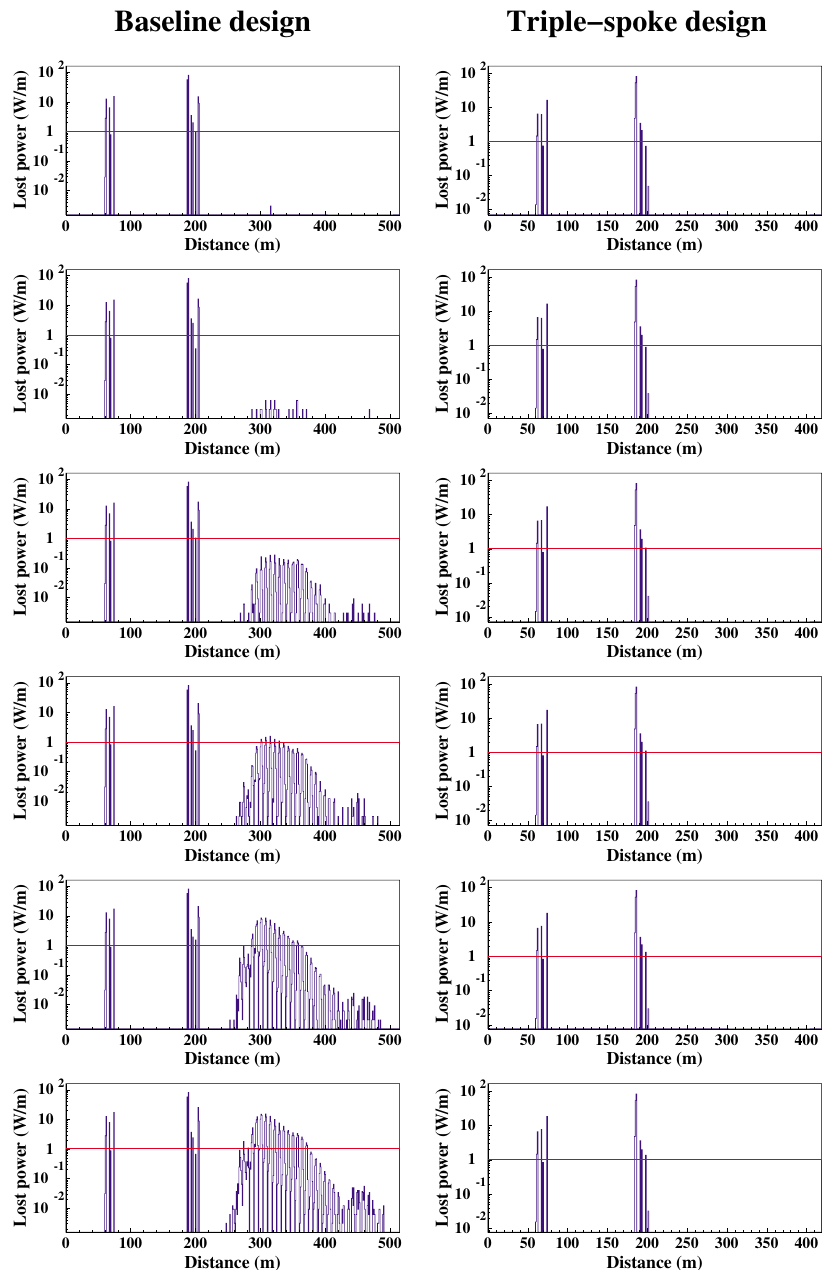
FIG. 16. (Color) Beam power lost along the accelerator in W = m for both the baseline and triple-spoke design and the error combinations of Table II. The plots are for combination 1 (top) to combination 6 (bottom), respectively. The horizontal line shows the 1 W = m limit to not exceed for hands-on maintenance. The first two peaks on each figure correspond to the losses at the two strippers, which are controlled